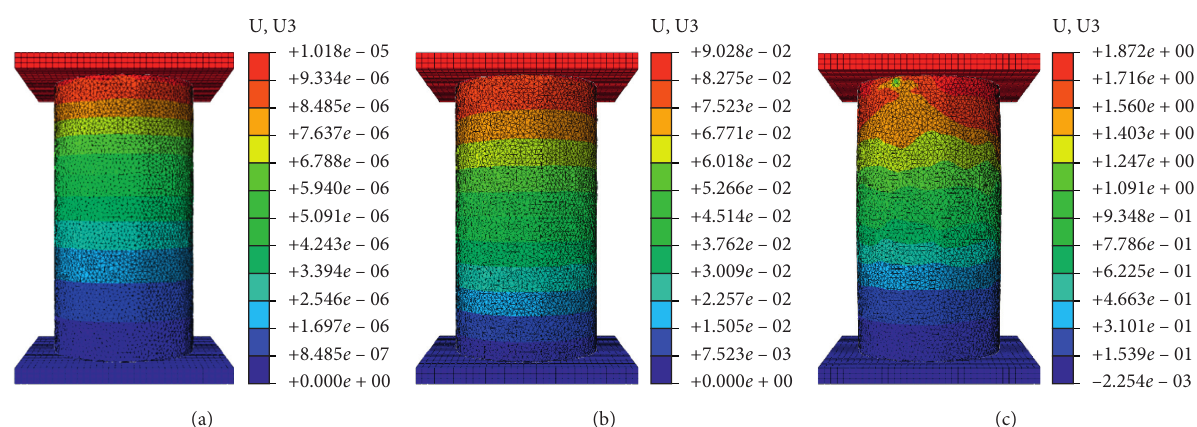
Figure 15: Vertical displacement nephogram of rock sample subjected to pH � 1 HCl for 90 days. (a) The initial stage of compression. (b) The middle stage of compression. (c) The later stage of